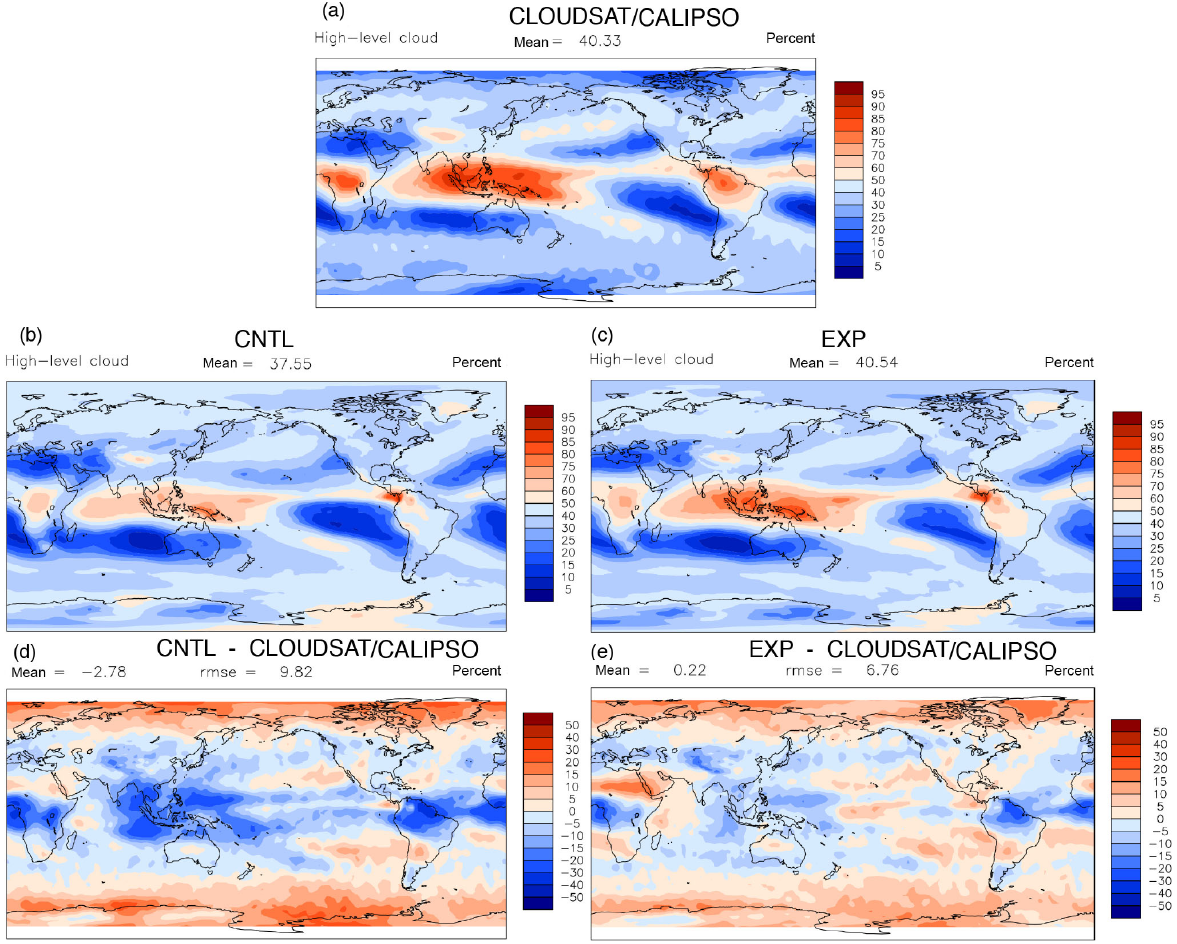
Figure 4. The spatial distribution of high cloud amount in the (a) observation, (b) CNTL, (c) EXP, (d) CNTL – observation, and (e) EXP –